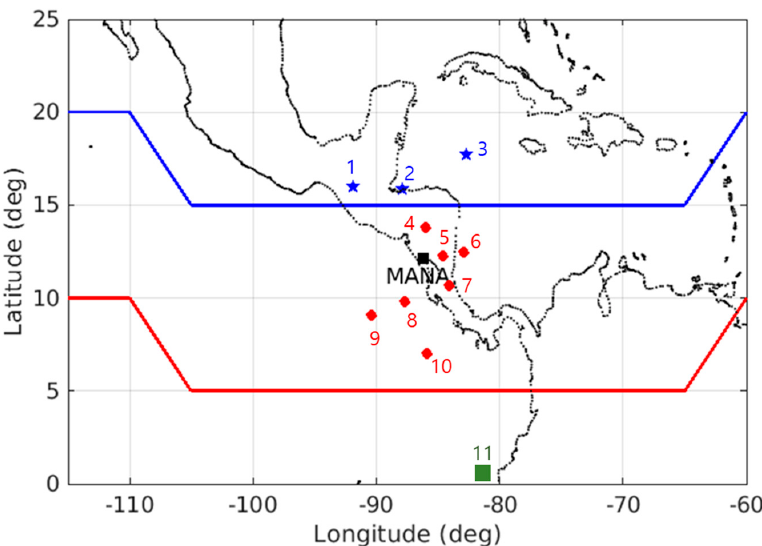
Figure 2. GPS Satellite ionosphere pierce points (IPPs) visible at MANA station on 17 March 2015 .